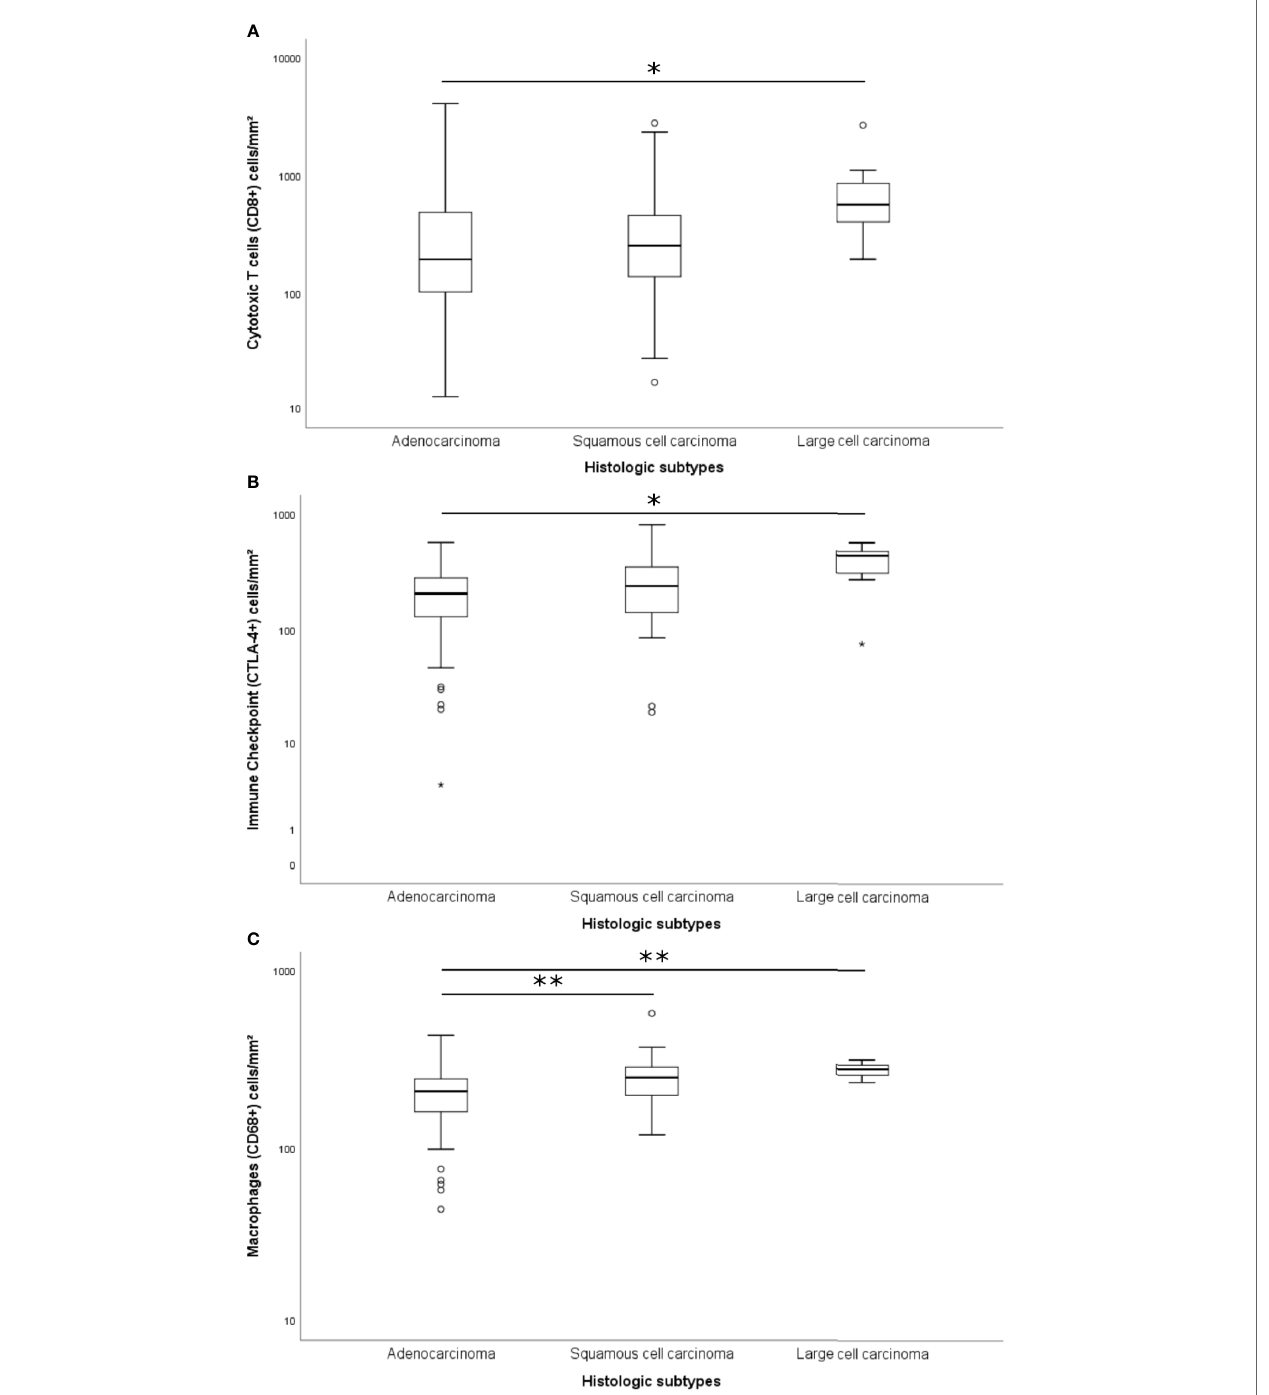
FIGURE 3 | Box plots of differentially expressed immune proteins among histological subtypes. Only the cytotoxic T cells CD8 + ( A ; P = 0.034; Adjusted P-value [ADC-LCC] = 0.034), the immune-checkpoint CTLA-4+ ( B ; P = 0.012; Adjusted P-value [ADC-LCC] = 0.024), and the macrophages CD68+ ( C ; P < 0.001; Adjusted P-value [ADC-SqCC] = 0.005, and Adjusted P-value [ADC-LCC] = 0.007) presented signi fi cative difference between NSCLC subtypes. The y-axis was shown on the log scale. The association between immune cells and histological types was calculated by the non-parametric Kruskal-Wallis test. The horizontal bars represent the statistical difference between groups; the pairwise comparison was adjusted by Bonferroni ’ s correction for multiple tests (Adjusted P-value). (*) was used when P > 0.05, and (**) was used when P ≥ 0.01. ADC, adenocarcinoma; LCC, large cell carcinoma; SqCC, squamous cell carcinoma; CTLA-4, Cytotoxic T-Lymphocyte Associated Protein